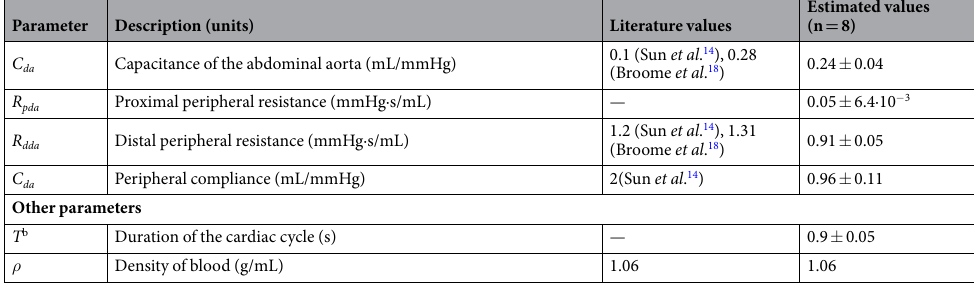
Table 3. Parameter estimates for the eight subjects included in the study. Values are given as mean ± standard error, unless otherwise stated. a Parameter values were assigned according to literature 14